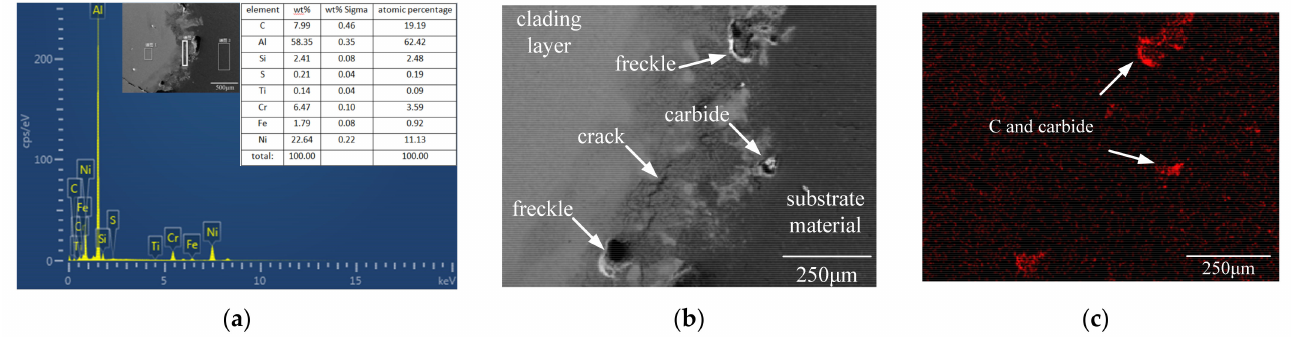
Figure 4. Energy spectrum and electron microscope images of the binding region. ( a ) Binding zone of EDS. ( b ) Cross-section of SEM. ( c ) C